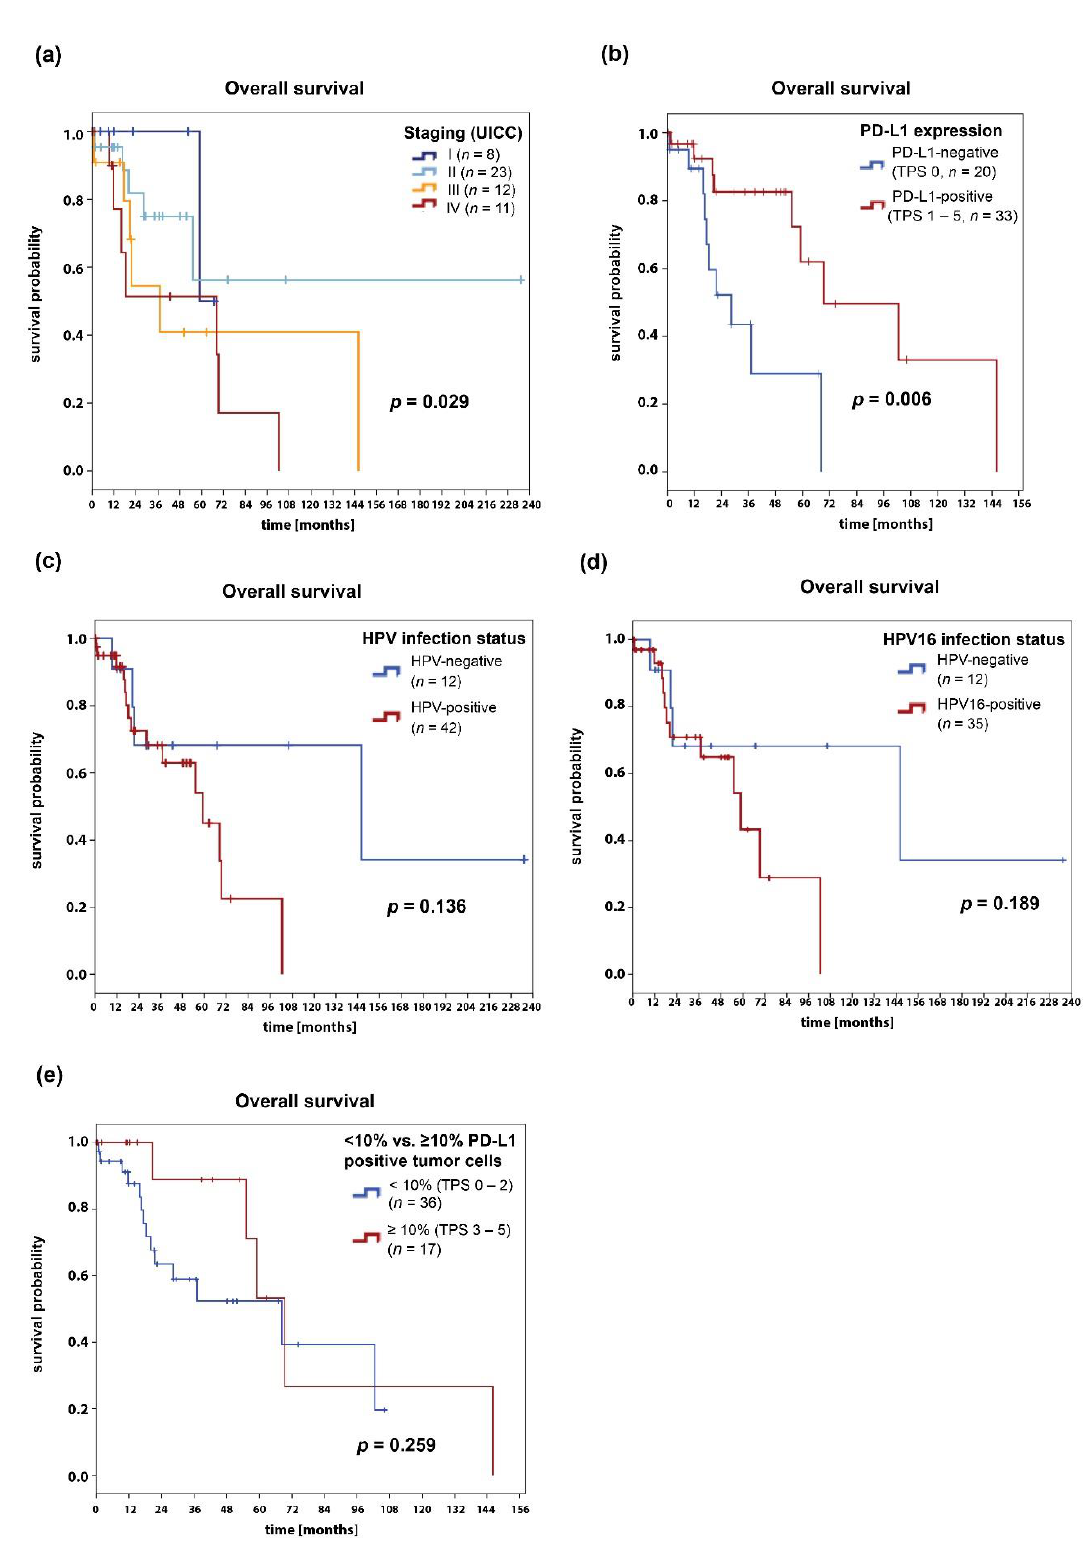
Figure 4. Survival analyses of the anal SCC patients. Kaplan–Meier curves show the overall survival depending on ( a ) tumor stage, ( b ) PD-L1 expression, ( c ) HPV infection status, ( d ) HPV16 infection status, and ( e ) PD-L1 expression (cut-off value: 10% PD-L1 positive tumor cells). p -values were calculated with the log-rank test and p < 0.05 were considered significant.